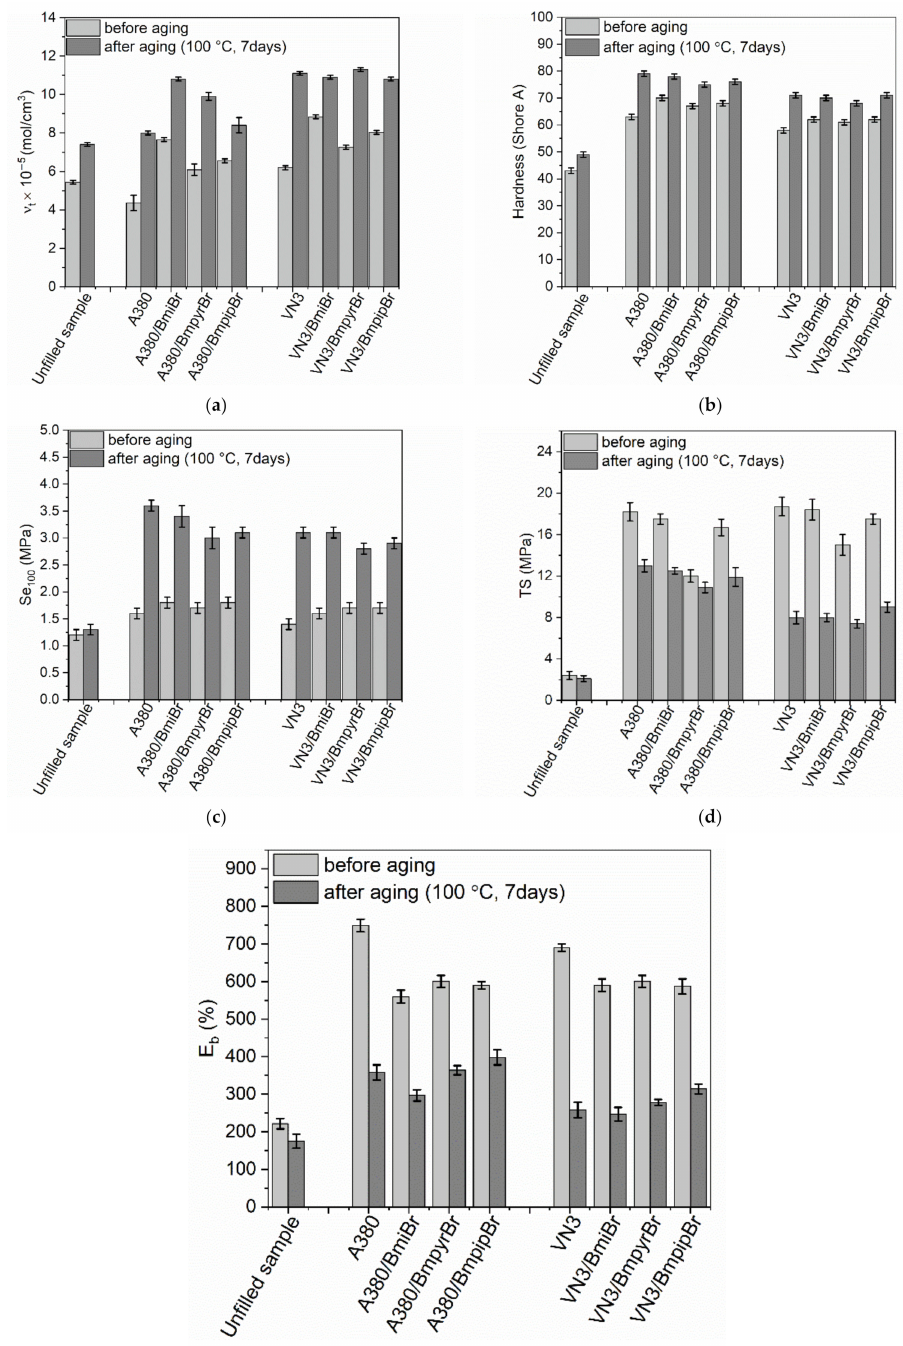
Figure 7. Effect of prolonged thermo-oxidation on the performance and crosslink density of SBR composites filled with silica A380 and VN3: ( a ) crosslink density; ( b ) hardness; ( c ) stress at 100% relative elongation; ( d ) tensile strength; ( e ) elongation at